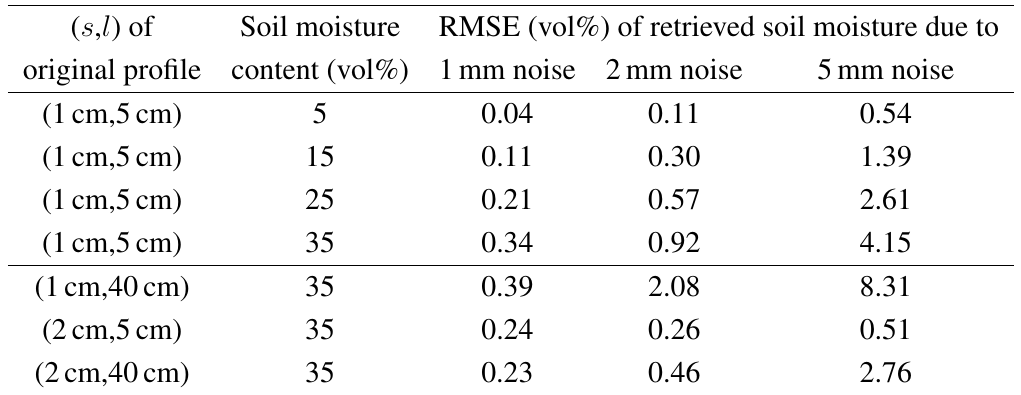
Table 4. RMSE values of the retrieved soil moisture contents due to roughness parameteri- zation errors, introduced by instrument